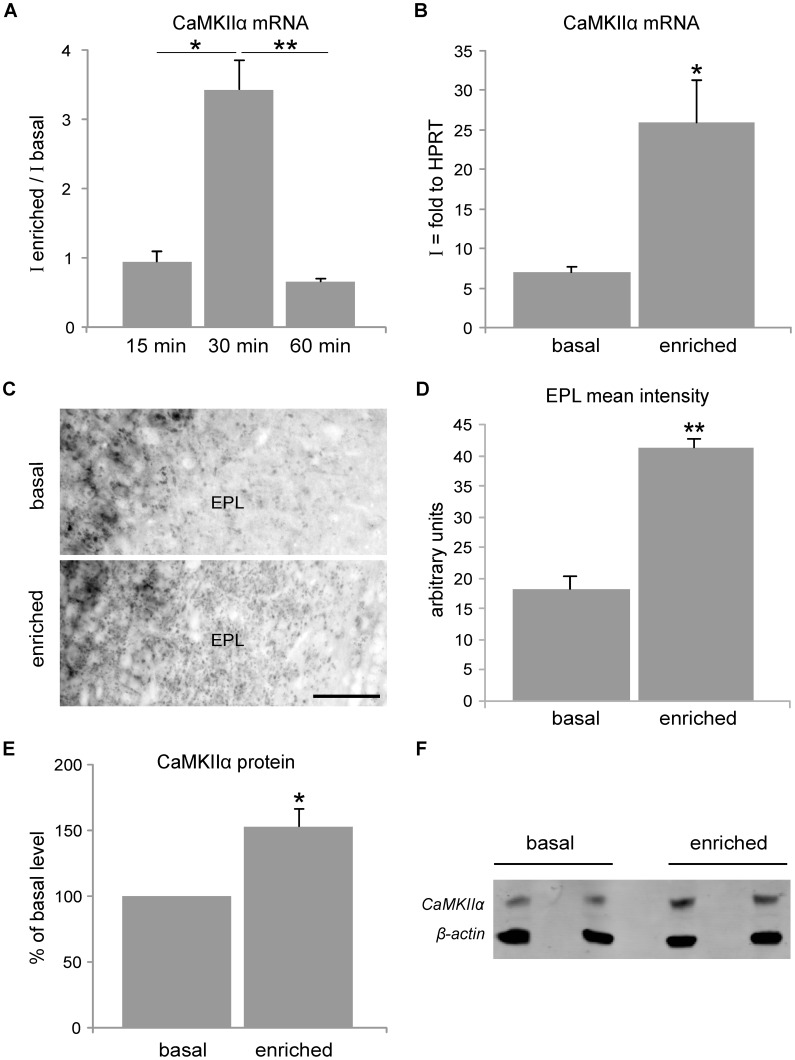
CaMKIIα mRNA synaptic localization is regulated by olfactory activity.
A, Mice were presented with a tea-ball containing either garlic and tarragon (“enriched”) or nothing (“basal”) for various durations. 30 min of this olfactory enrichment raises the levels of CaMKIIα mRNA in synaptosomes (SN) by 3.4-fold as compared to basal levels. No increase is observed after 15 min of exposure, and mRNA levels return to baseline (index ratio of 1) 60 min after exposure. “I” is the index of synaptic localization and represents the ratio of mRNA present in the SN fraction over the total quantity present in the OB homogenate. Error bars represent sem. (n = 3 for 15 min and 30 min, n = 2 for 60 min; *p = 0.005, **p<0.02, t-test) B, CaMKIIα index of synaptic localization rises from 7 in basal conditions to 26 upon 30 min of olfactory enrichment (n = 3; *p<0.02, t-test). C, D
In situ hybridization for CaMKIIα mRNA of control or 30 min enriched mice shows an increase of the EPL staining upon enrichment Scale bar: 50 µm. Quantification of the signal showed that it was increased by 2.3 upon enrichment (n = 2, p = 0.006). E,F Western blot of SN shows a 1.5 increase in CaMKIIα protein in enriched conditions versus basal conditions (n = 4, p<0.05). The results were normalized over β-actin signal.